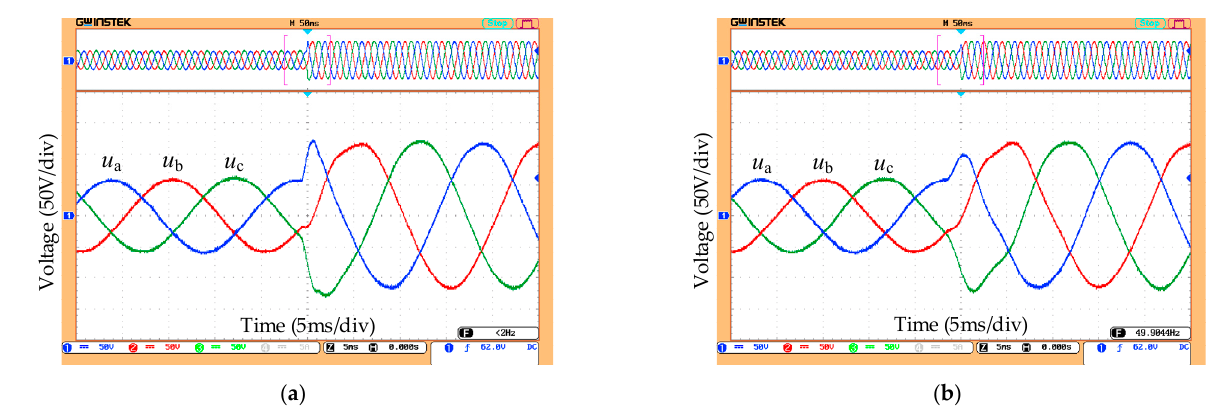
Figure 13. Experimental results under the reference voltage change: ( a ) Original LADRC scheme; ( b ) Proposed scheme. As shown in Figure 14, the voltage of the OL and PS schemes track well the reference voltage, 60 V and 120 V, and can recover within 4 ms, but the overshoot of the OL scheme is up to 134 V, which is greater than the PS scheme. The amplitude of the capacitor voltage is calculated from − 4 ( v + v + v ) /3, where v ( i = a , b , c ) represents the i -phase voltage sampled by the oscilloscope.